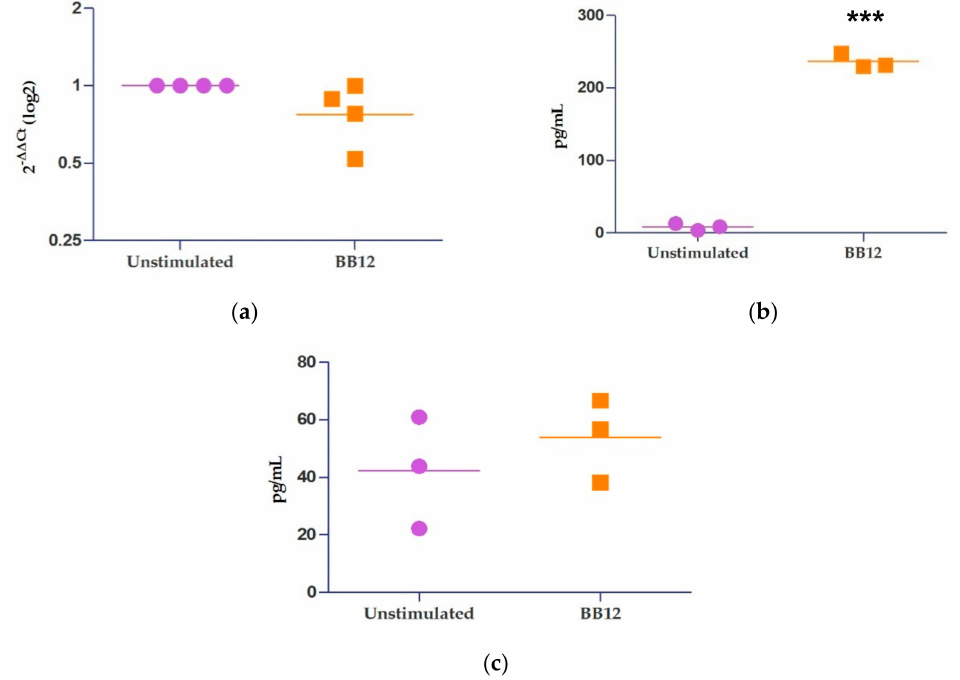
Figure 3. Production of IL-10, but not its expression is increased in BB12-stimulated moDCs. MoDCs were either left unstimulated or stimulated with BB12 (BB12) for 6 h; then, RNA was extracted from the cells and the relative expression of IL-10 was determined using RT-qPCR via the 2 − ∆∆ C t method. Peptidylprolyl Isomerase A (PPIA) expression was used as a housekeeping gene to normalize the data ( a ), y-axis represents foldchange of IL-10 cytokine from unstimulated or BB12-stimulated moDCs. Culture supernatants of moDCs that were unstimulated or stimulated with BB12 for 24 h were assayed for ( b ) IL-10 and ( c ) IL-12 using Enzyme-Linked ImmunoSorbent Assay (ELISA), where y-axis represents picograms per milliliter. Data were analyzed using a t -test, n = 4, *** p < 0.001. Graphs represent the geometric mean ( a ) and mean ( b , c ). Each point represents one pig and an independent